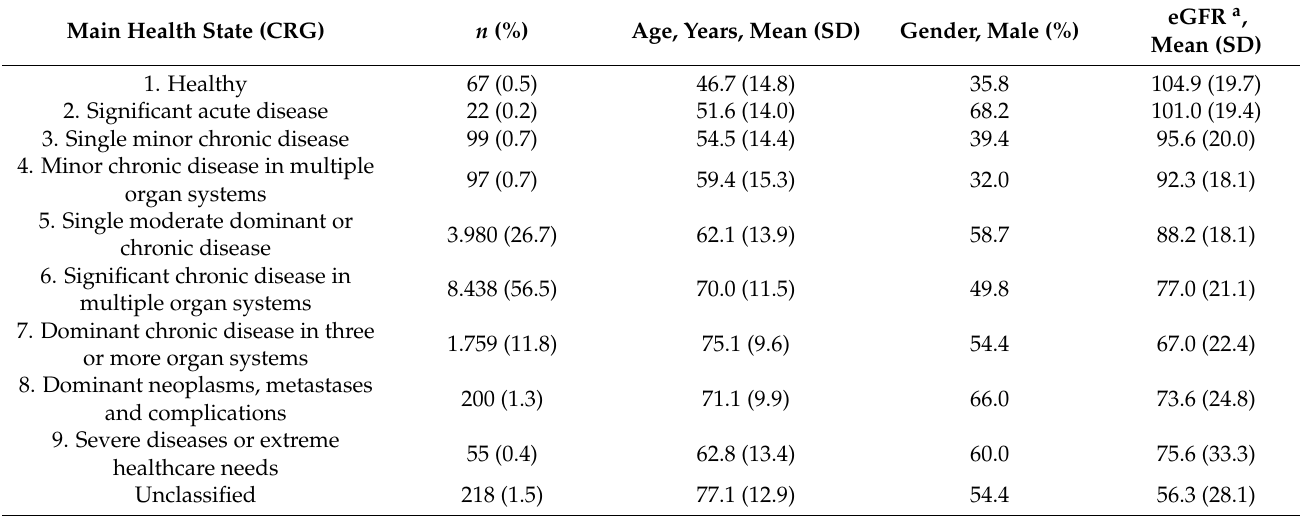
Table 1. Characteristics and classification according to CRGs of patients with T2D and data on eGFR and albuminuria ( n = 14,935)